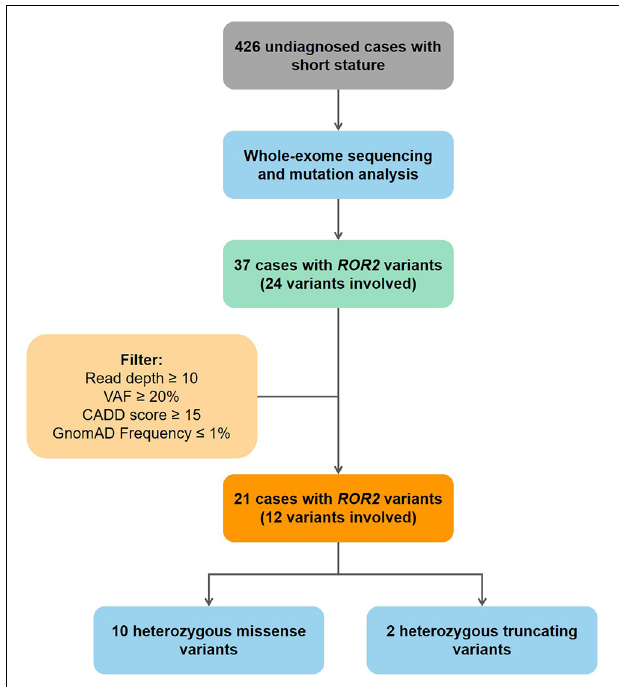
FIGURE 1 | Flowchart of patient enrollment and mutation screening. VAF, variant allele frequency; CADD, combined annotation dependent depletion